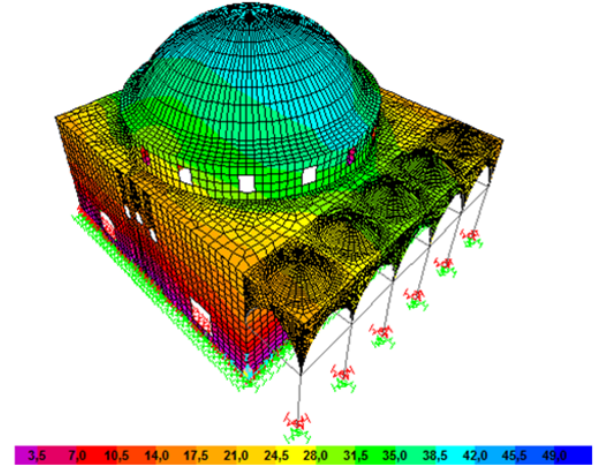
Figure 9. Maximum displacements contour diagram of the mosque with 16 window openings under dead load and earthquake load in the y direction (G +